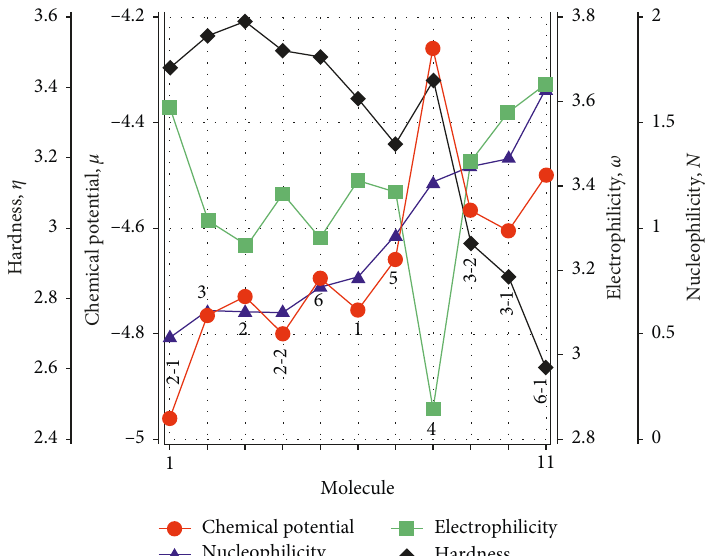
Figure 5: Quantitative structure-reactivity descriptor relationships of the synthesized molecules and its tautomers. Each of molecules 2 and 3 has two other tautomers, while molecule 6 can exist in two tautomeric shapes (Figure 4). Similar figure is obtained in the solution phase (ACN). Table 4: Relative energies and frontier orbital energies of the tautomers of 2 (denoted as 2-1 and 2-2 ), 3 ( denoted as 3-1 and 3-2), and 6 ( denoted as 6-1) in acetonitrile Tautomer